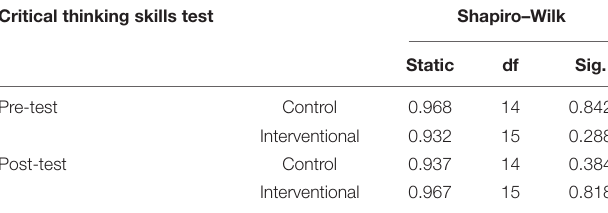
TABLE 3 | Shapiro–Wilk normality test results.